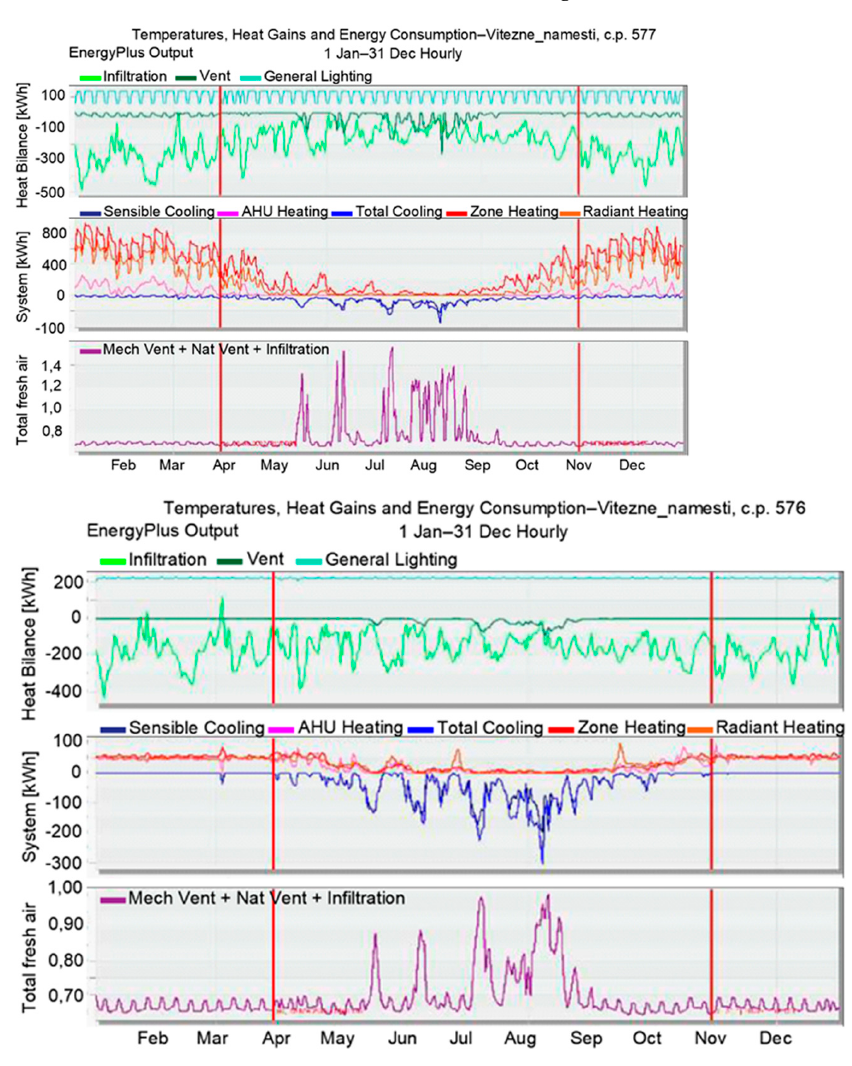
Figure 16. The Pattern of Energy Consumption. Table 6. Heat Transfer Coefficients Before and After Reconstruction (Insulation).